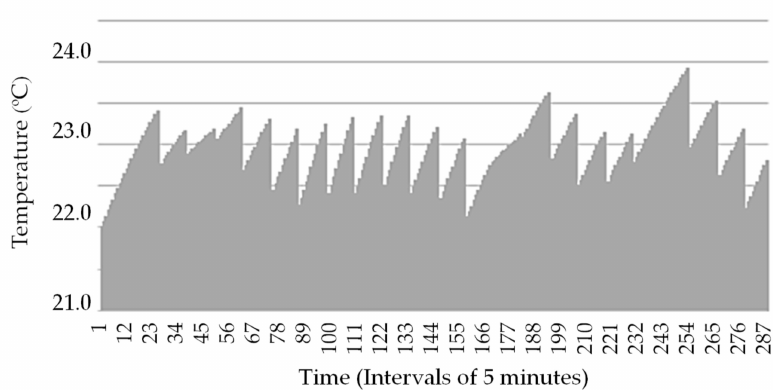
Figure 7. Evolution of the environmental temperature in the smart house, during the day, considering the real time pricing scheme.